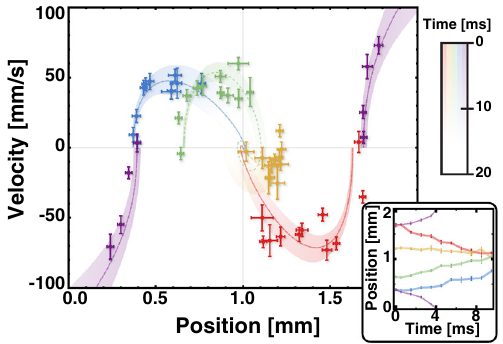
FIG. 4. Phase space (and position space, inset) trajectories for atoms trapped in a two-photon, optical frequency comb MOT. Smooth curves are fits to a damped harmonic oscillator, with fit uncertainties shown as bands. Purple features show the behavior when the ML beam polarizations are intentionally reversed and exhibit an anticonfining force. Error bars are statistical over repeated